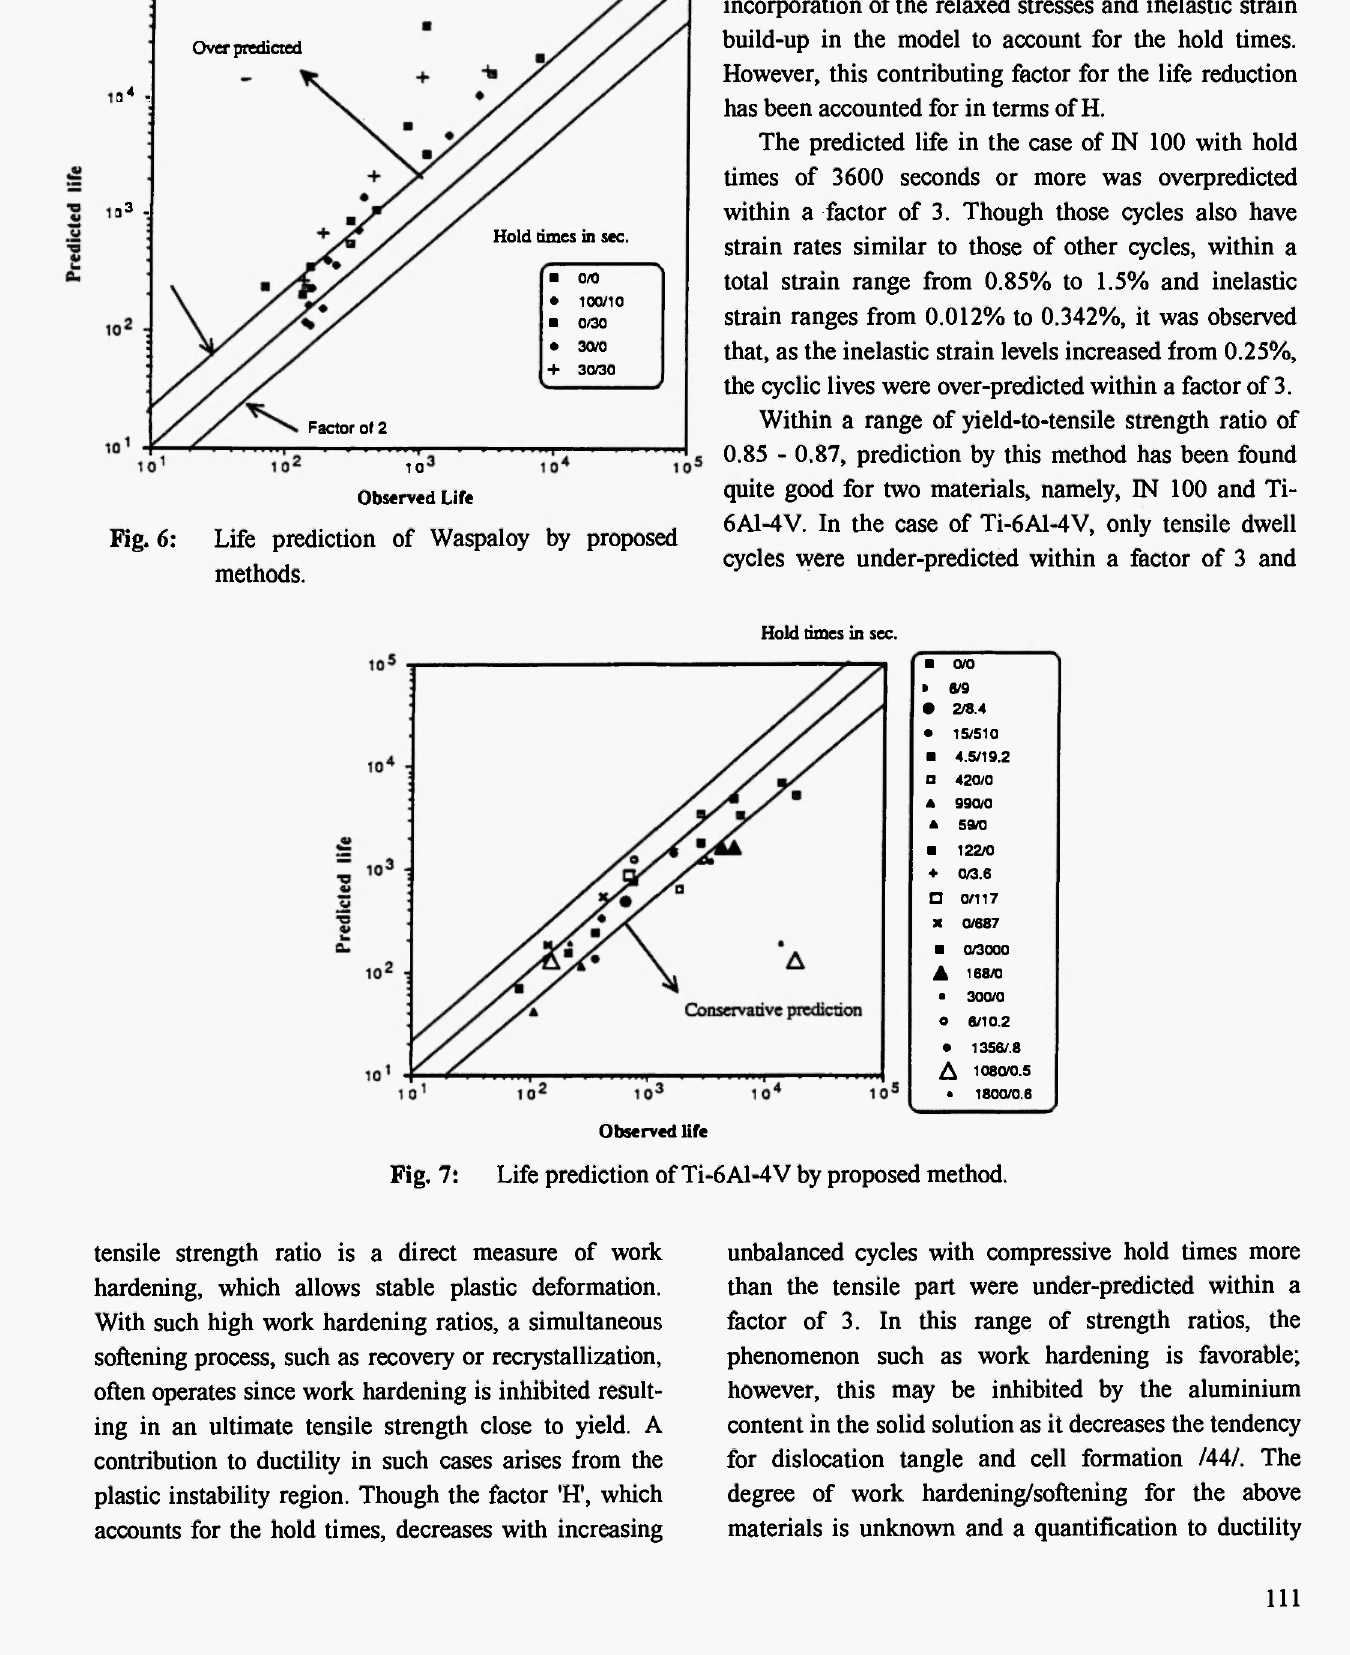
Fig. 6: Life prediction of Waspaloy by proposed methods.